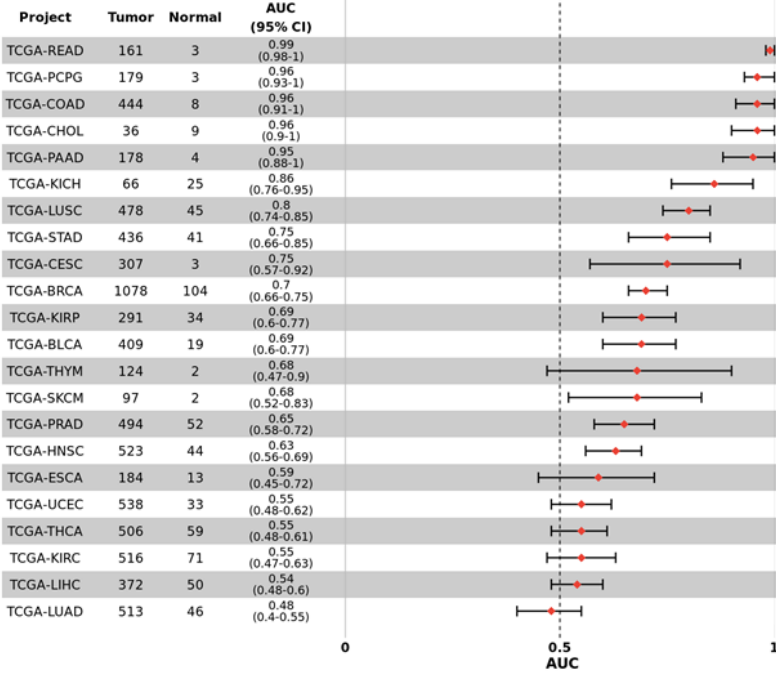
Figure 1. miR-194-5p expression in The Cancer Genome Atlas (TCGA) pan-cancer: ( A ) Pan-cancer expression of miR-194-5p in TCGA. Data are presented as “− delta CT” using box and whisker plots. **, p < 0.005; ***, p < 0.0005; n.s., not significant. ( B ) Forest plot visualizing pan-cancer survival analysis across all TCGA projects.